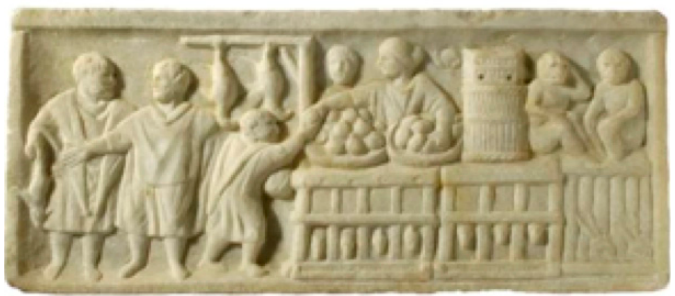
Figure 2. Two Barbary macaques’ representations of a Roman marble relief found in Via della Foce at Ostia, Parco Romano Ostia Antica, (21 × 54 cm) dating from the second century CE.